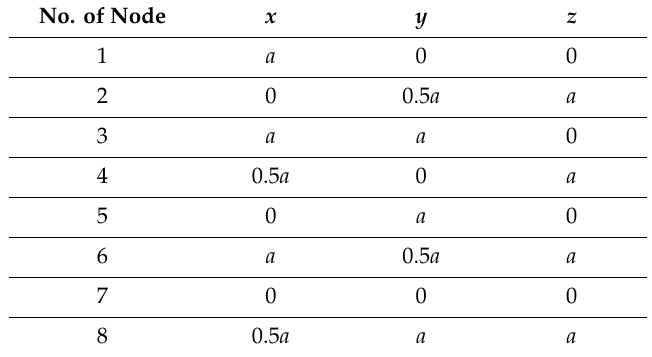
Table 2. Coordinates of the nodes of the single modified Quartex module.